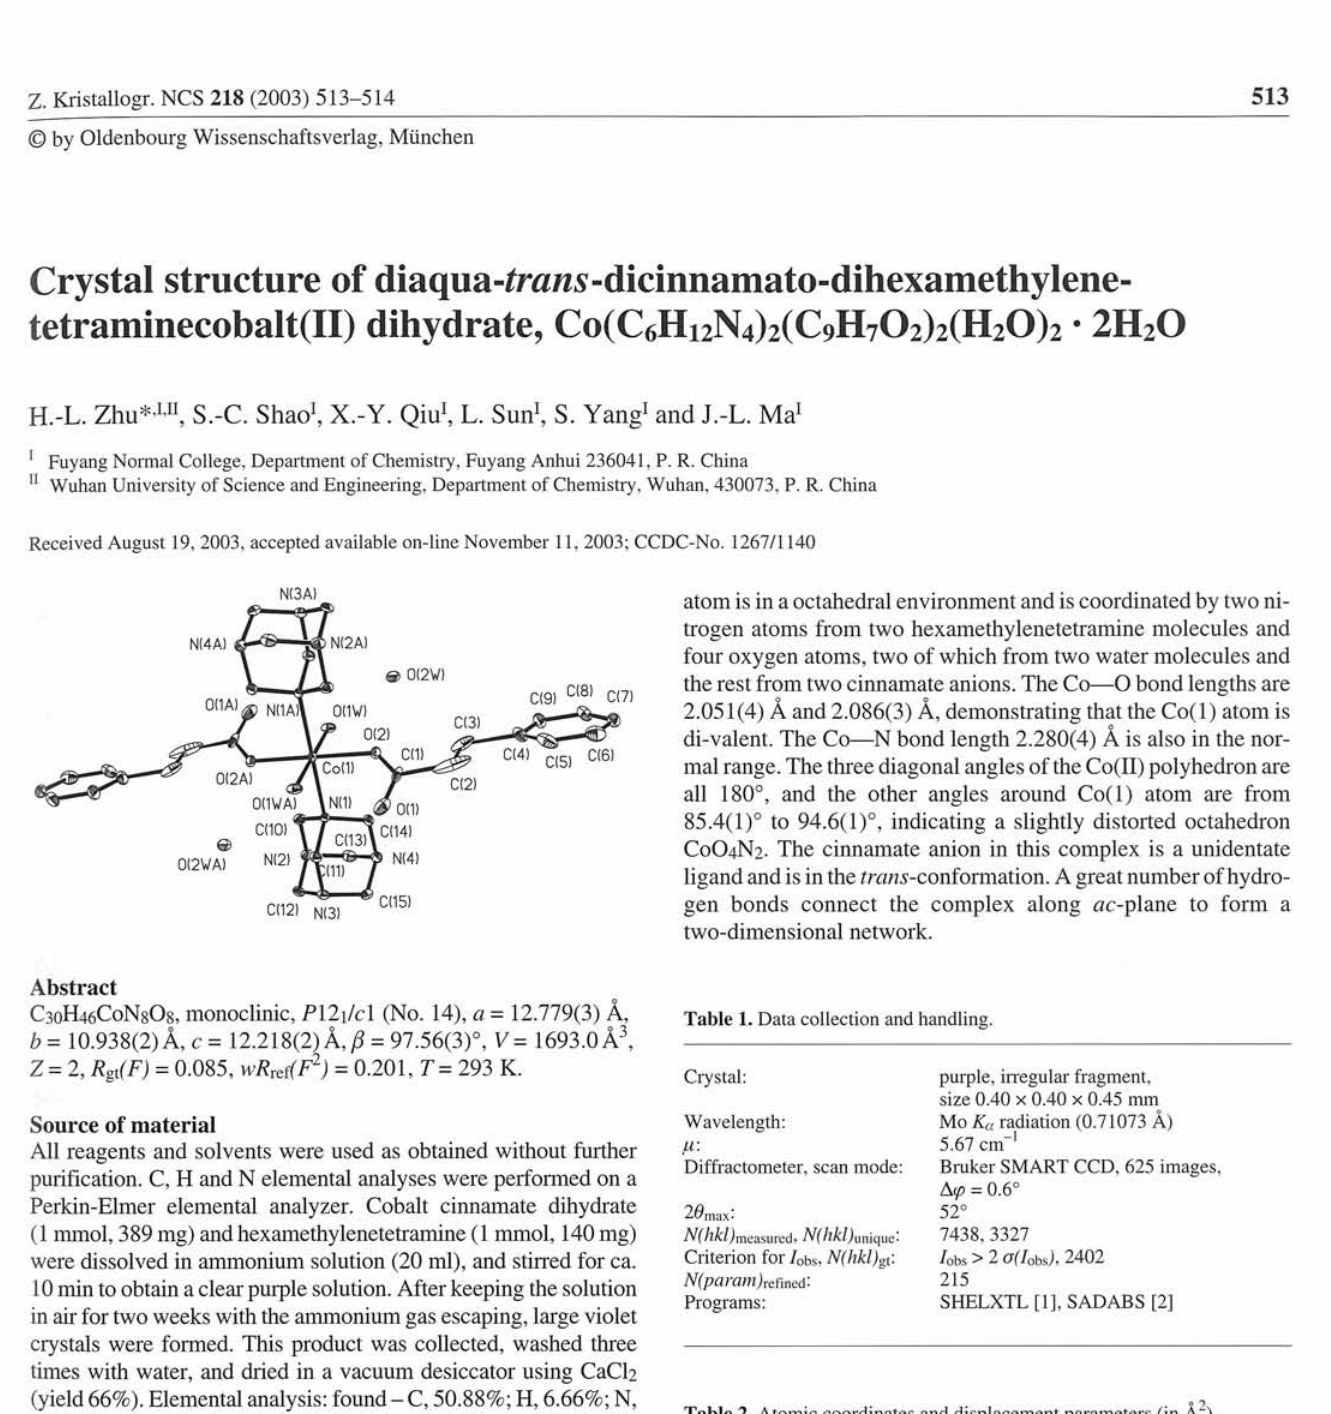
Table 2. Atomic coordinates and displacement parameters (in